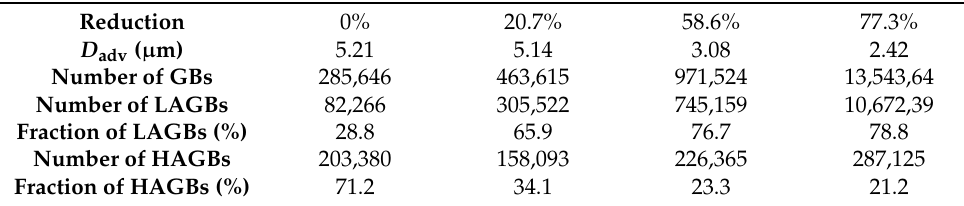
Table 7. Statistical data of the grain size and grain boundary variations.